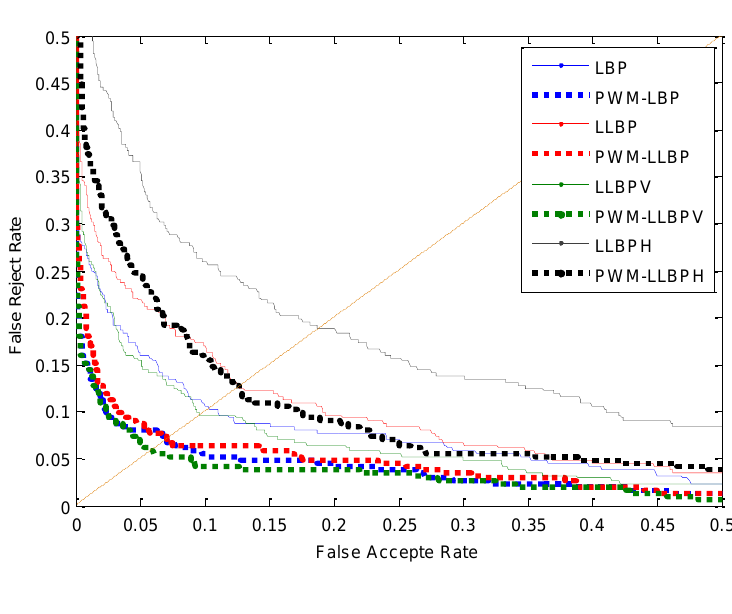
Figure 16. ROC curves by different